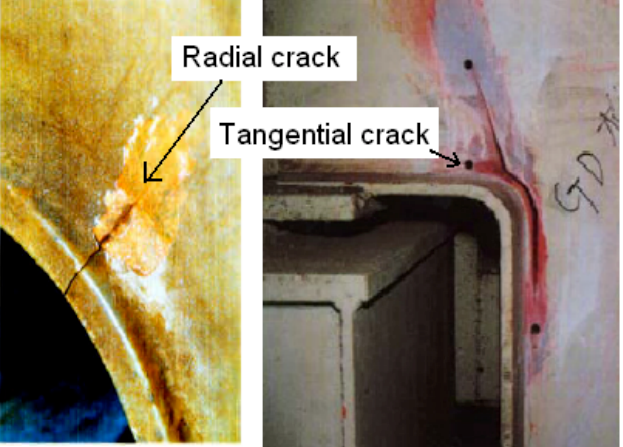
Figure 5. Examples of radial and tangential cracks [5].